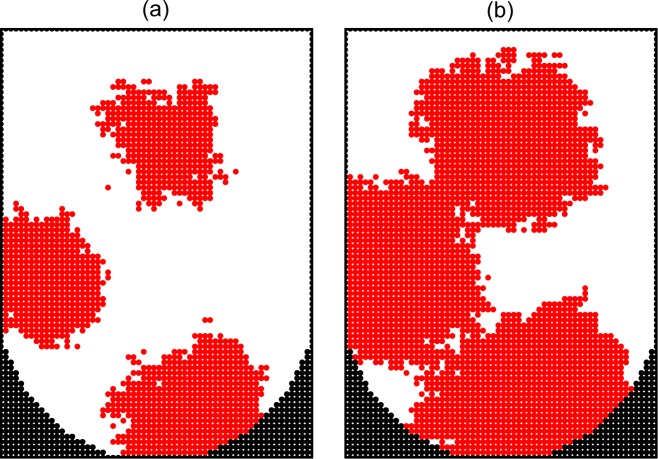
Monte Carlo simulation of cell proliferation and spheroid formation in the microwells.Cross sections of a microwell along the main axis at ϑ = 0.2 (a) and 0.4 (b) in the absence of cell diffusion and cell-surface adhesion (pdiv = 1, ϵcs = 0). The well and cells are represented by black and red circles, respectively.